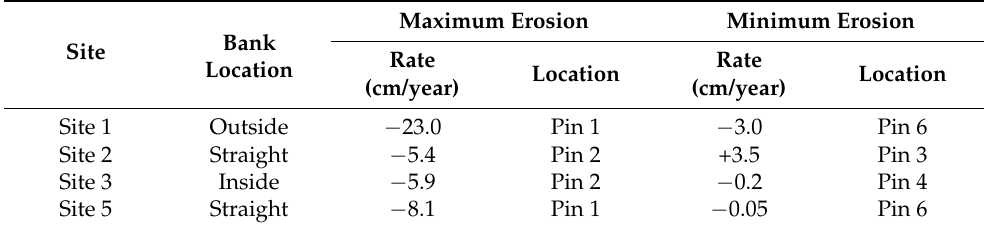
Table 5. Erosion rate calculated from USGS erosion pin